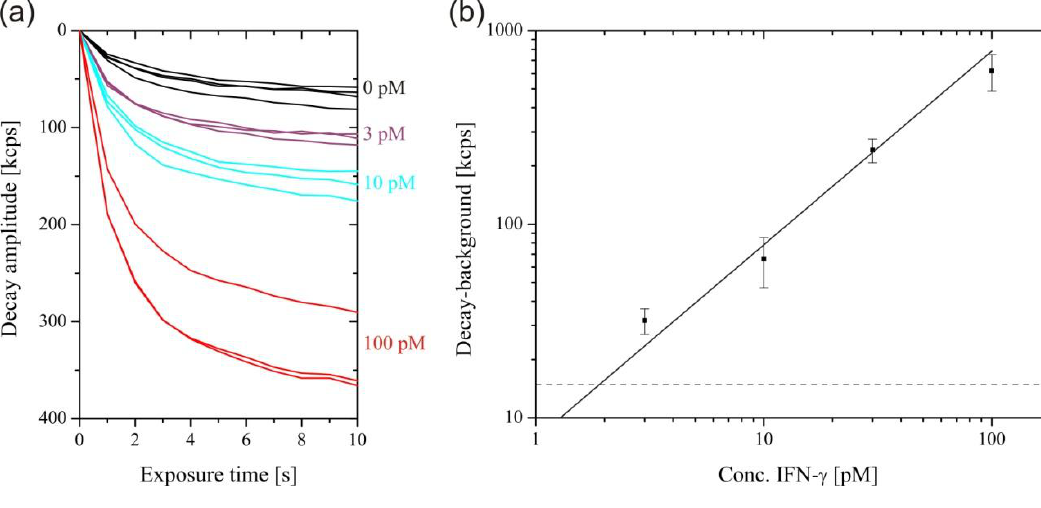
Figure 4. Sensitive readout after 700 s with 1 mW excitation. ( a ) Photobleaching decays of the SAF intensity. ( b ) Plot of the photobleaching amplitudes after 11 s, minus the background (zero concentration decay) against IFN-γ concentration. A straight line through the origin was fitted through the data points (Adjusted R-squared = 0.980). The dashed line corresponds to the 3σ value of the zero concentration measurement.